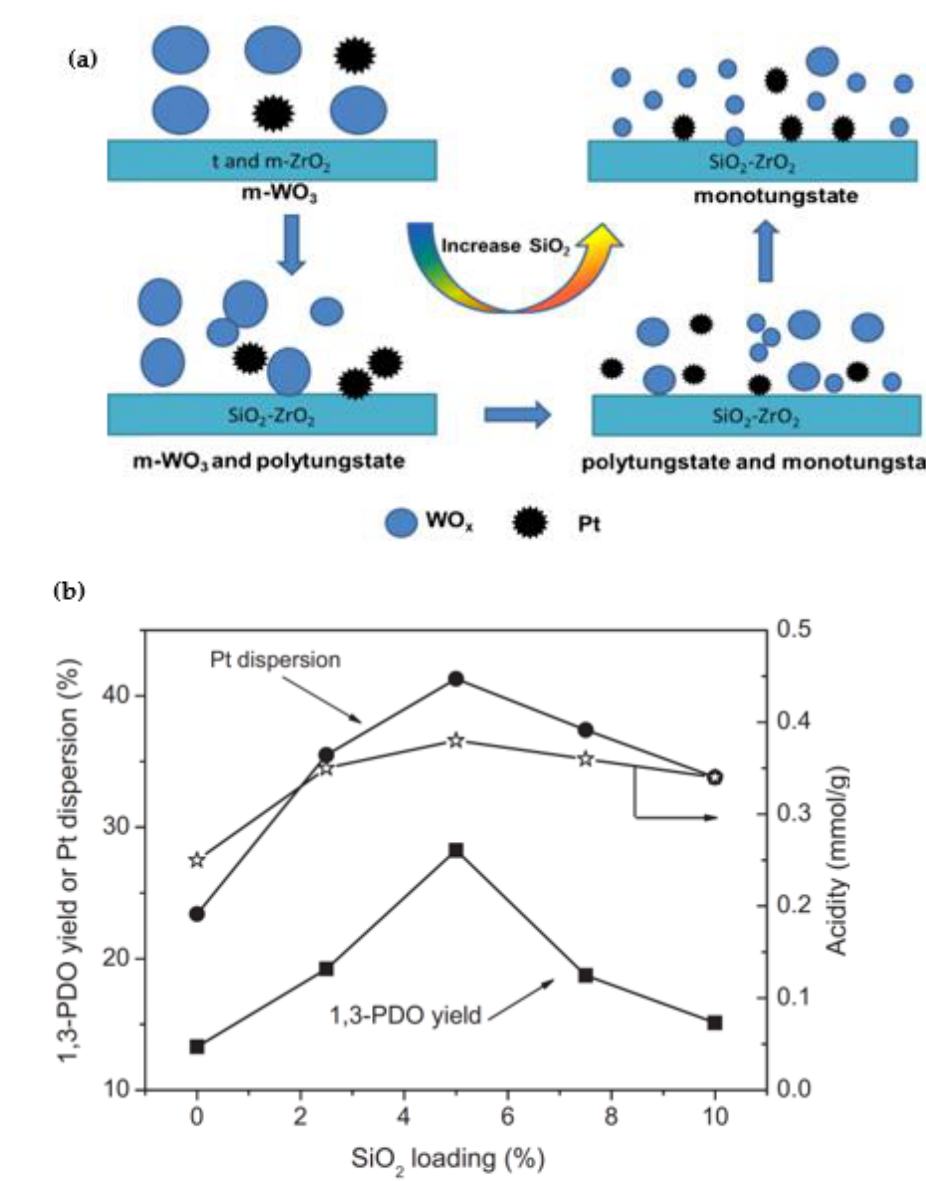
Figure 16. ( a ) The generation of polytungstate and monotungstate species on the Pt/WO x /SiO 2 /ZrO 2 catalysts [124] ( b ) The yield to 1,3-PG as a function of the SiO 2 content. Reproduced from [124] with permission from Elsevier.